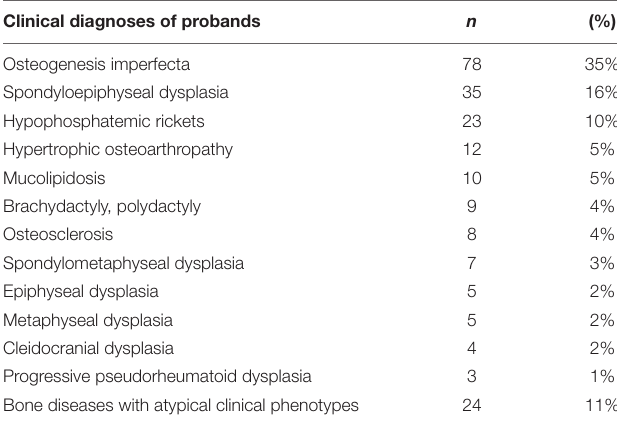
TABLE 1 | Clinical diagnoses of 223 probands who were suspected with genetic skeletal dysplasia.